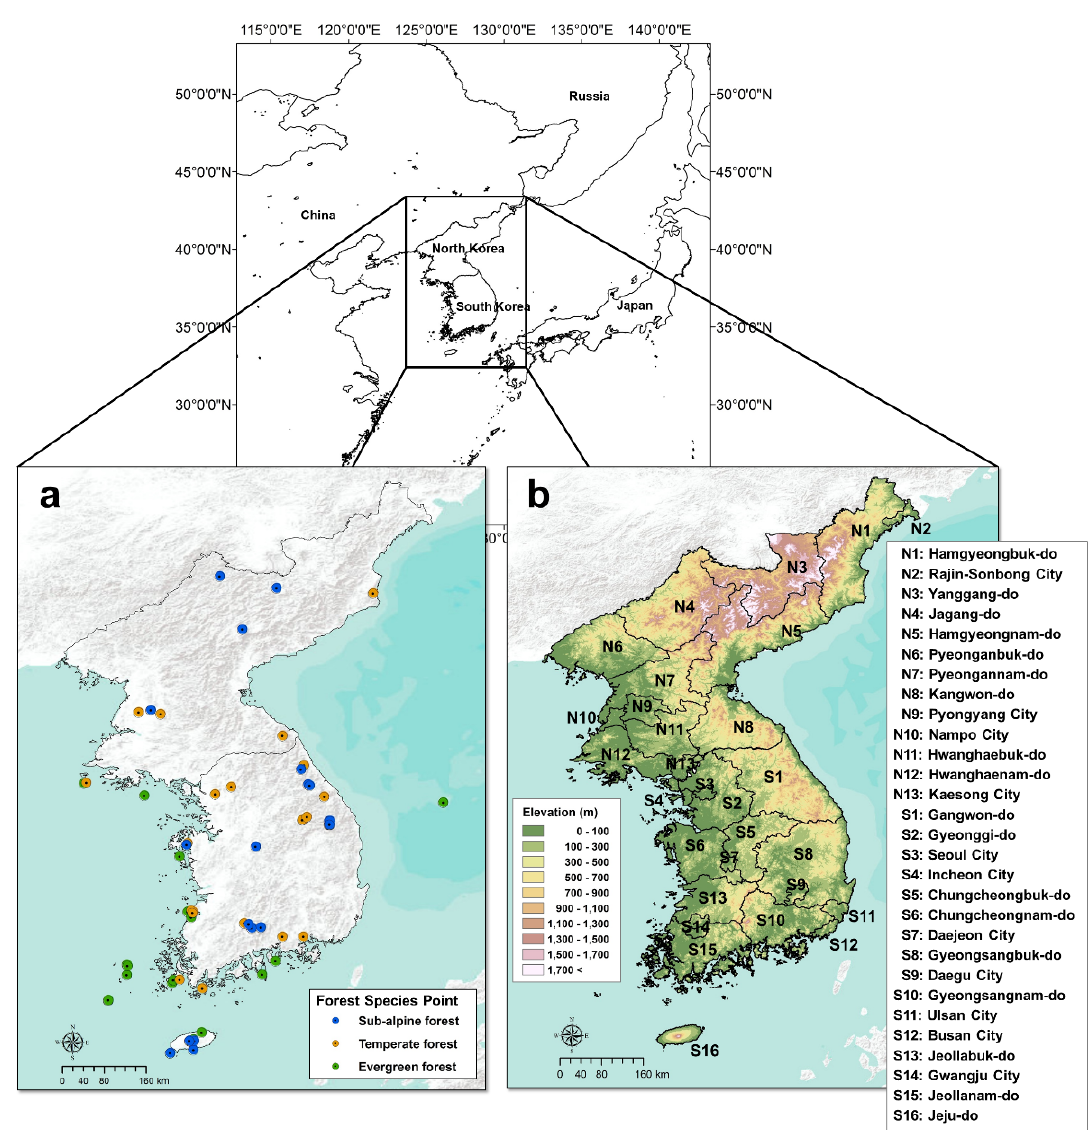
Figure 1. Study area (( a ): forest species sites used in this study, ( b ): administrative boundary with topographical information).